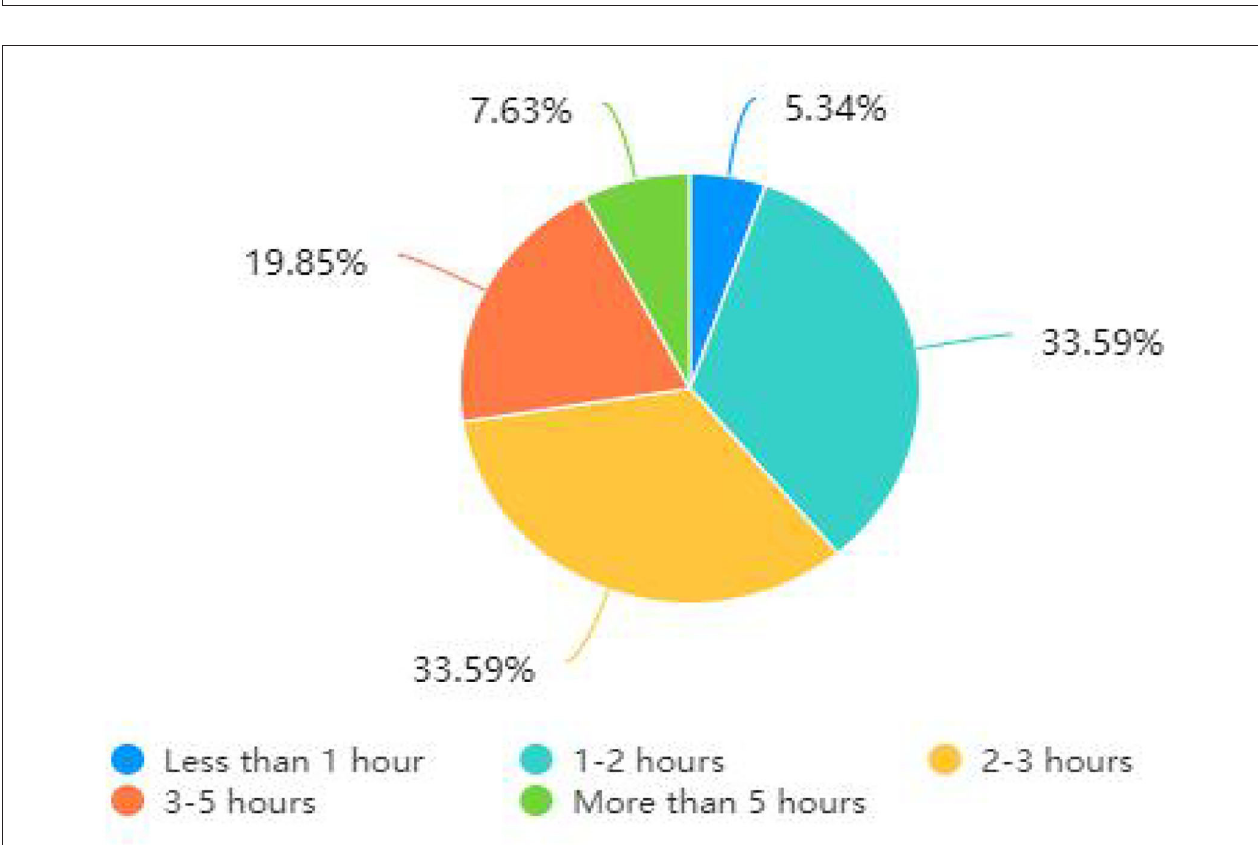
FIGURE 3 | Time spent daily on social media platforms during the COVID-19 outbreak.